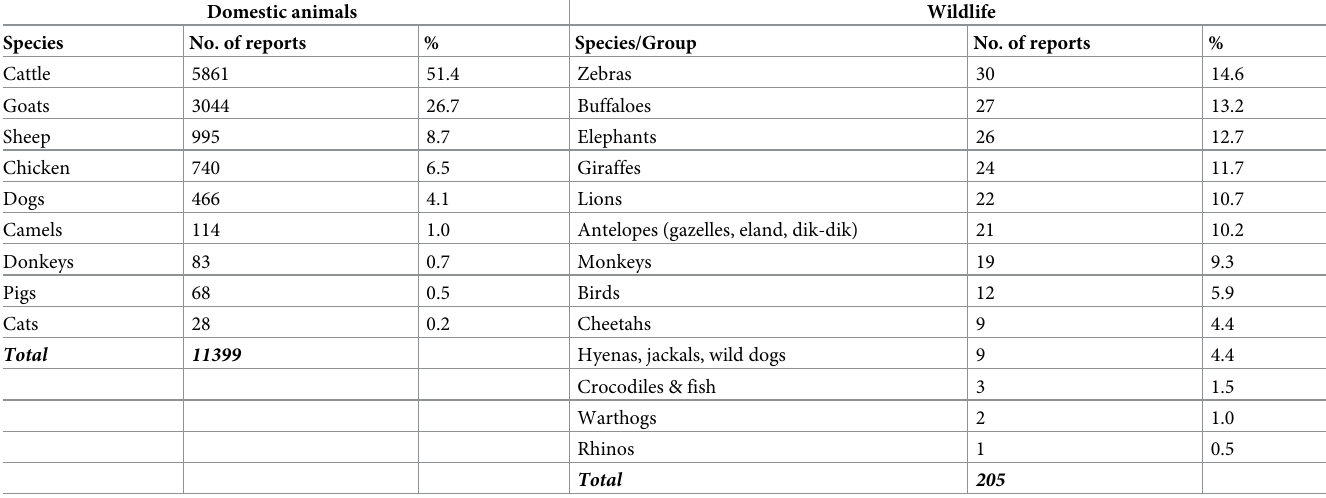
Domestic animals